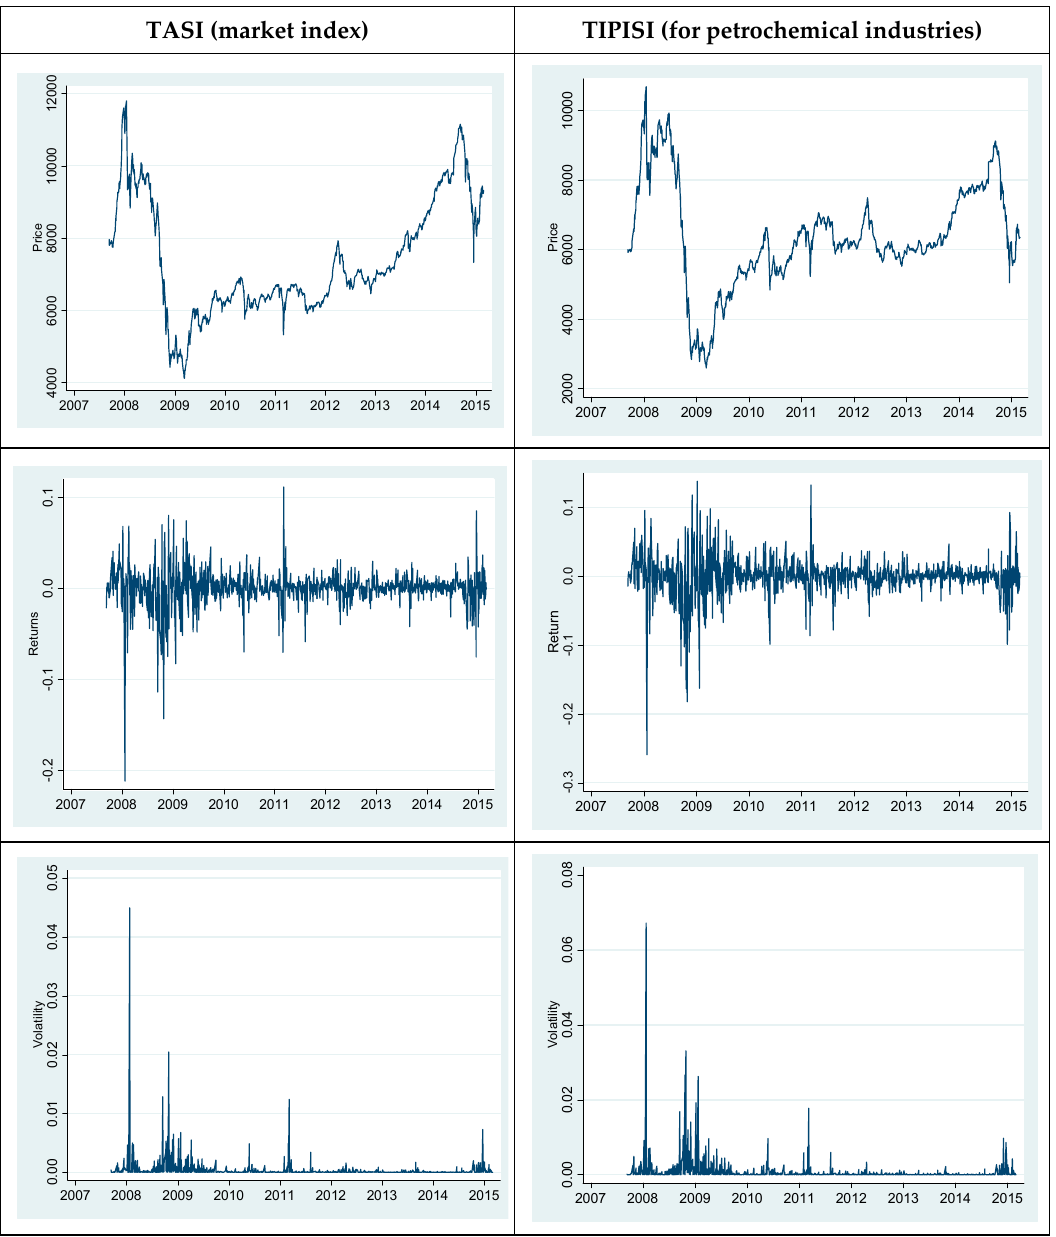
Figure 2. Daily prices, returns and volatility for the TASI and TIPISI during the period from January 2007 to June 2014.